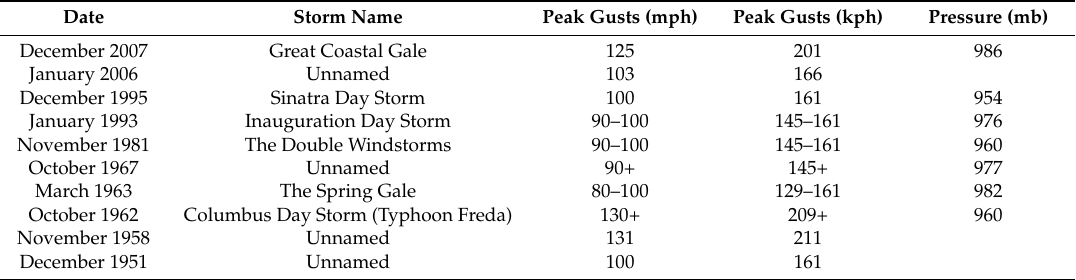
Table 1. Windstorms of the central and northern coast of Oregon with gusts of at least 119 km/h (Category 1 hurricane on the Saffir-Simpson Hurricane Wind Scale).